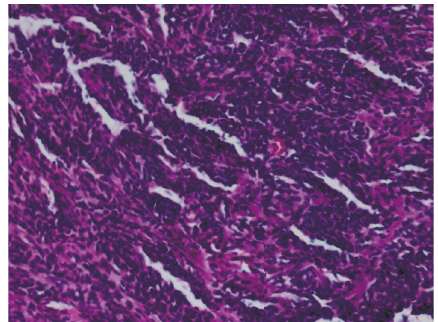
Figure 4: 20x magnification of mesenchymal